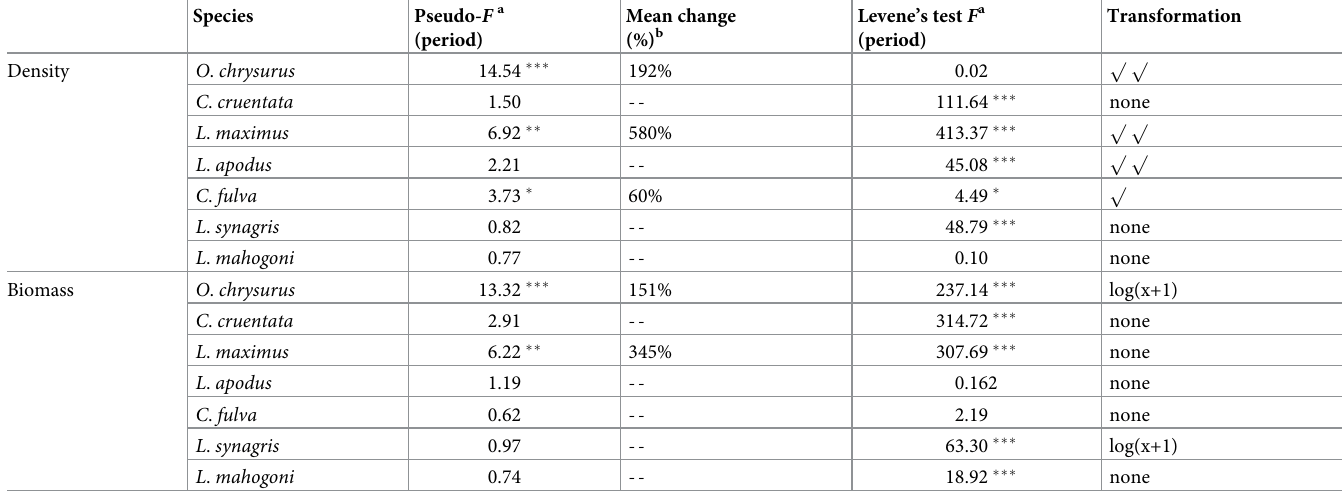
Table 7. Summary of species-specific pairwise tests of density and biomass (LPNR).